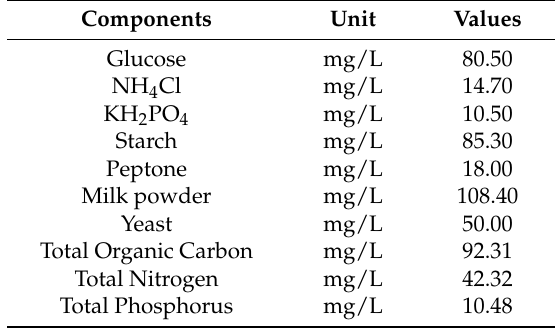
Table 1. Composition of the synthetic municipal wastewater used in this study